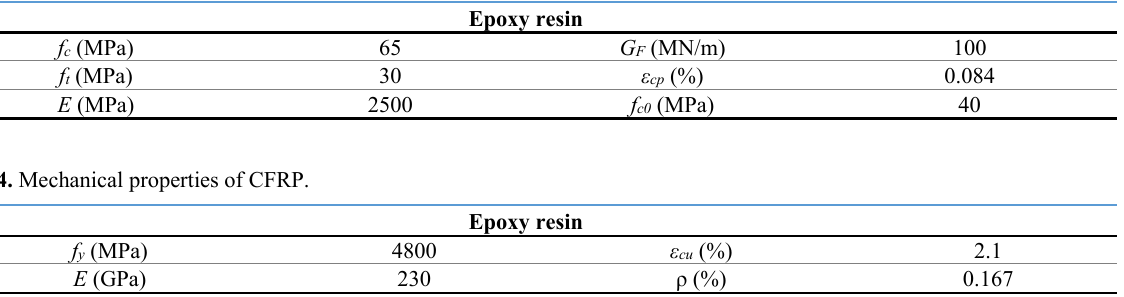
Table 3. Mechanical properties of epoxy resin.